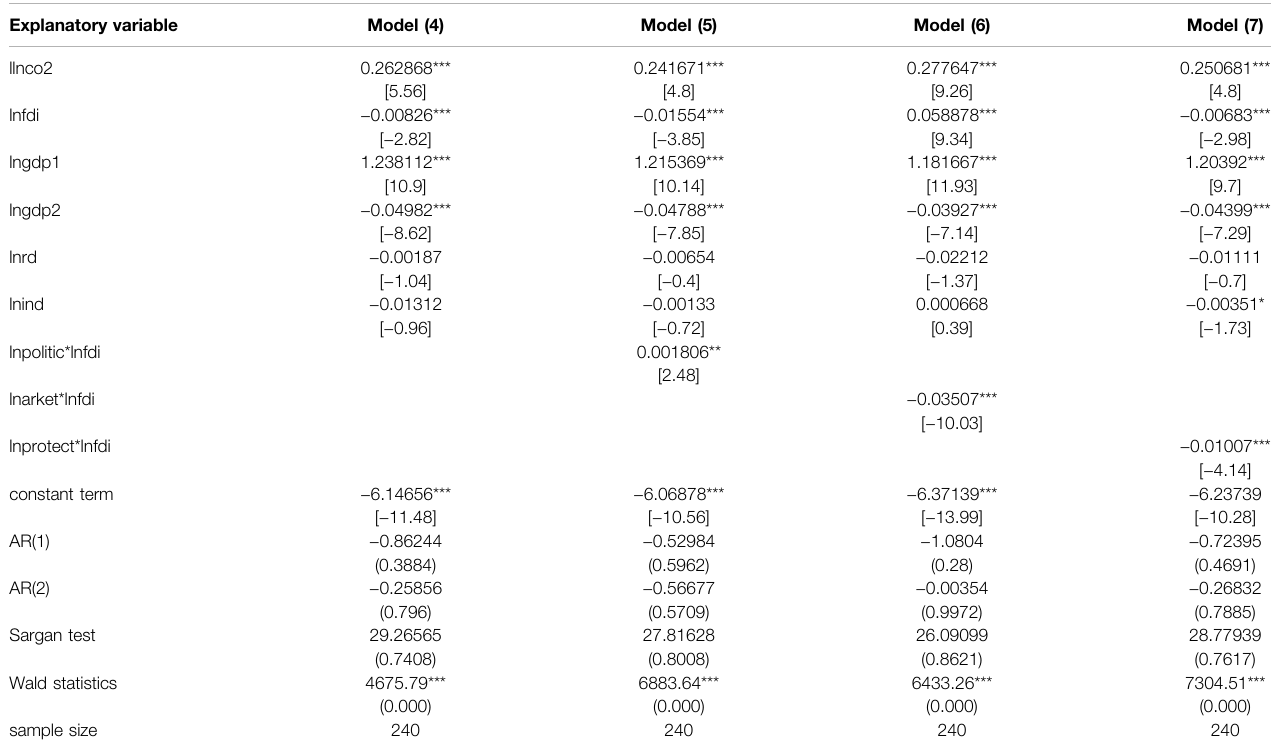
TABLE 6 | All-sample interaction